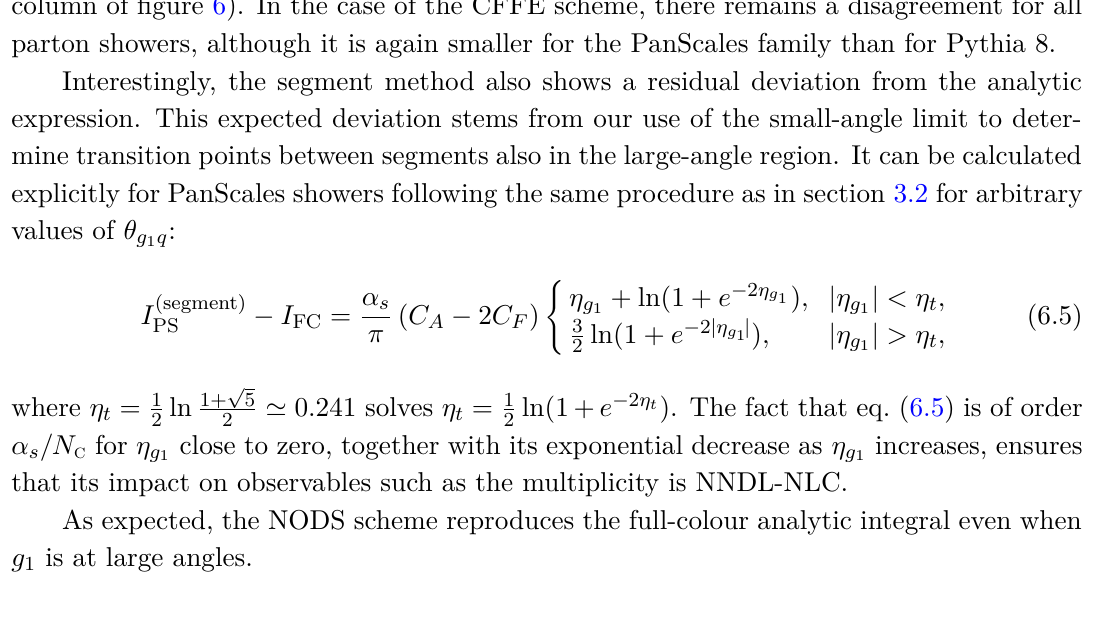
Figure 6. Normalised deviation of the integrated rate of parton-shower soft emission (from a ¯ qg 1 q system), relative to analytic full-colour result, i.e. π N c ( I PS − I FC ) , with I FC as given in eq. (6.3). α s The results are shown for several parton showers and colour schemes for emission from a ¯ qg 1 q system. The kinematics of g are indicated in each column, and the integral bounds are set to 1 η cut = 30 . The results are colour-coded green and red, respectively, according to whether the result is consistent with zero, or